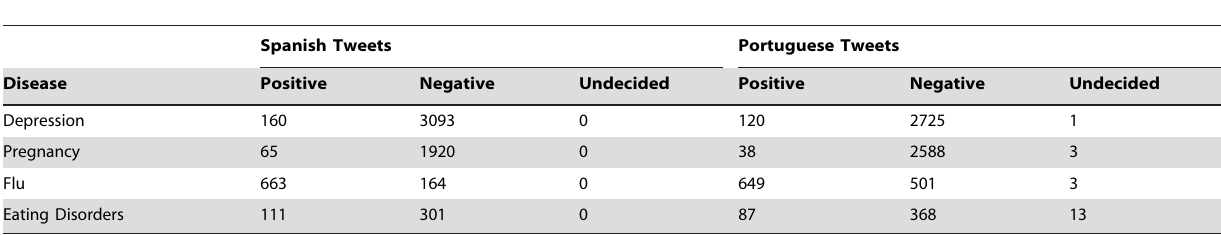
Table 4. Number of tweets labelled as positive, negative and undecided.